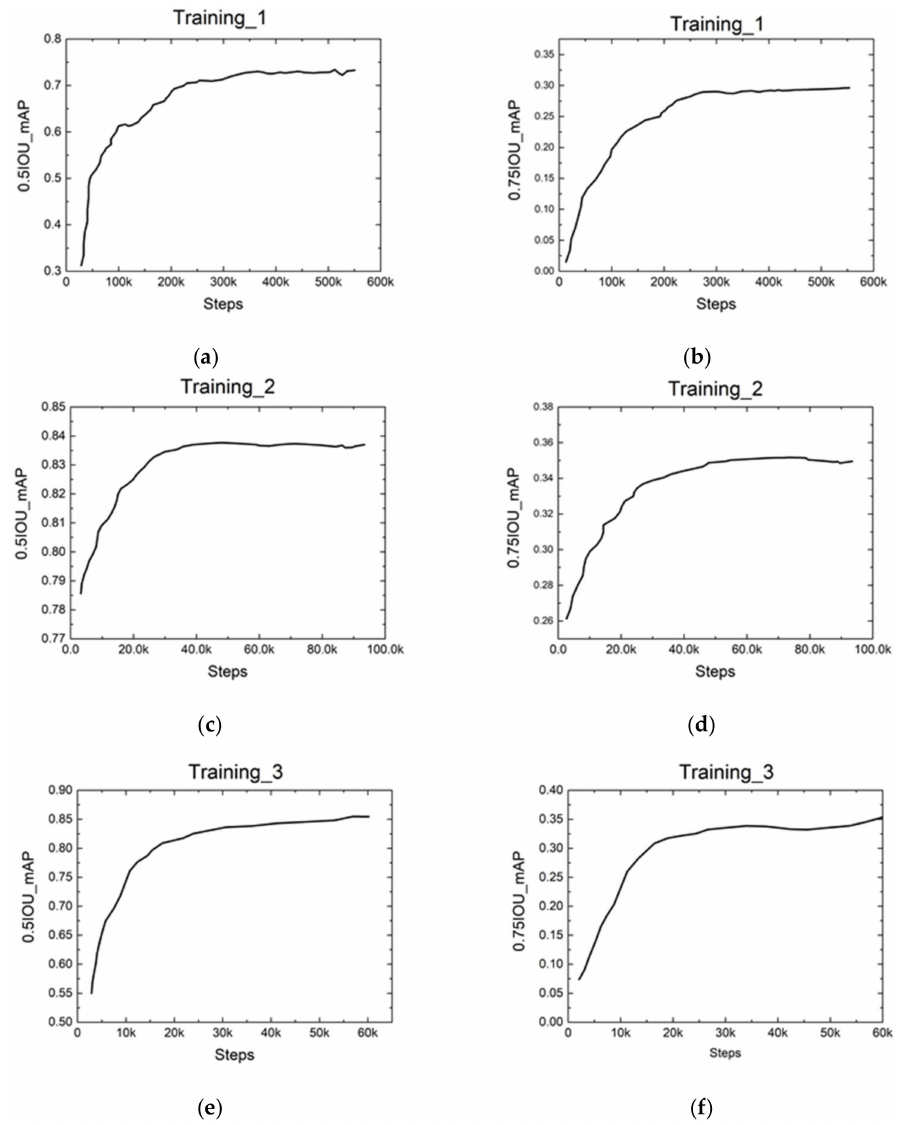
Figure 13. The results of mAP over the training process: ( a , b ) the results over the first training step; ( a ) the increase in mAP@0.5IOU over steps; ( b ) the increase in mAP@0.75IOU over steps; ( c , d ) the results over the second training step; ( c ) the increase in mAP@0.5IOU over steps; ( d ) the increase in mAP@0.75IOU over steps; ( e , f ) the results over the third training step; ( e ) the increase in mAP@0.5IOU over steps; ( f ) the increase in mAP@0.75IOU over